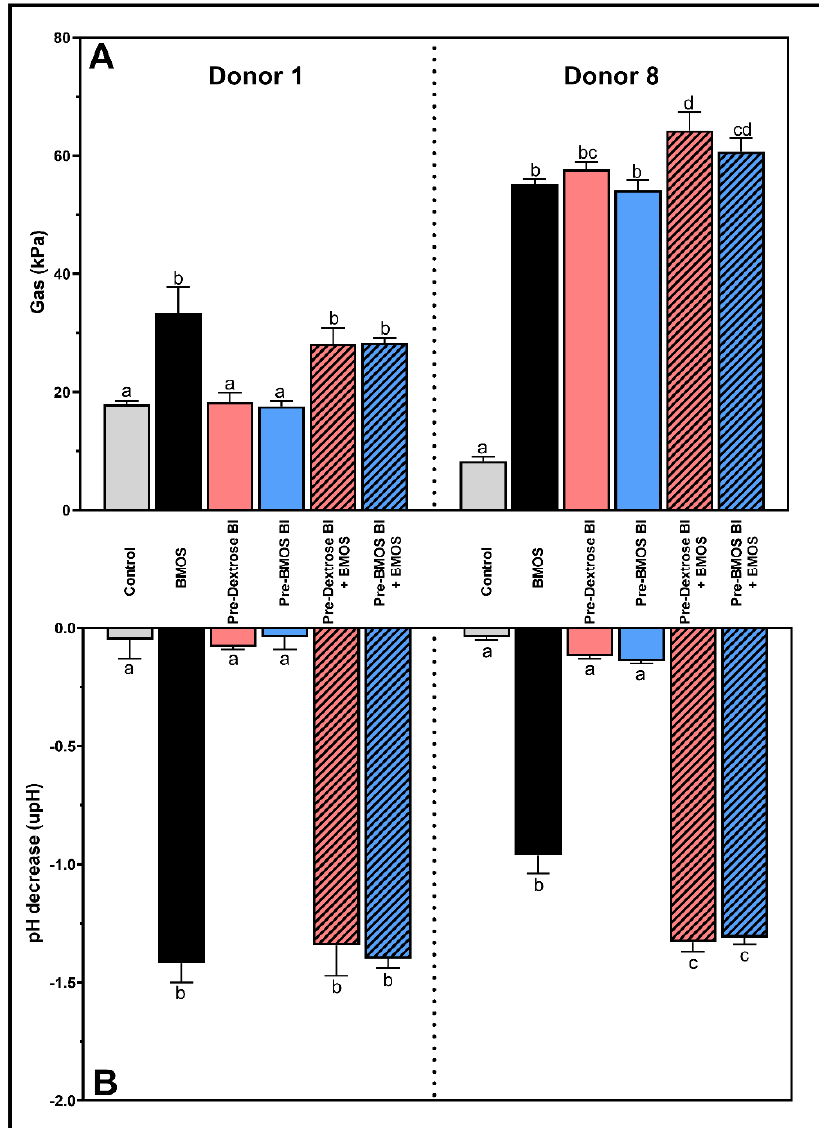
Figure 3. Mean ( ± standard deviation) microbial metabolic activity in terms of gas production (kPa) ( A ) and pH decrease (upH) ( B ) upon a 48 h fermentation of 5 g / L BMOS containing 1.5 × 10 7 CFU / mL of B. lactis previously grown on either Dextrose (Pre-Dextrose Bl + BMOS, n = 3) or BMOS (Pre-BMOS Bl + BMOS, n = 3), by the infant fecal microbiota of Donors 1 and 8, versus their respective controls (Control, Pre-Dextrose Bl and Pre-BMOS Bl, n = 3). Significant di ff erences between the di ff erent formulations within each donor are indicated with di ff erent letters (a, b, c, d), as tested with a one-way ANOVA with Tukey’s HSD post hoc test ( p < 0.05). In contrast, when at least one letter is shared between two treatments, there was no significant di ff erence between these